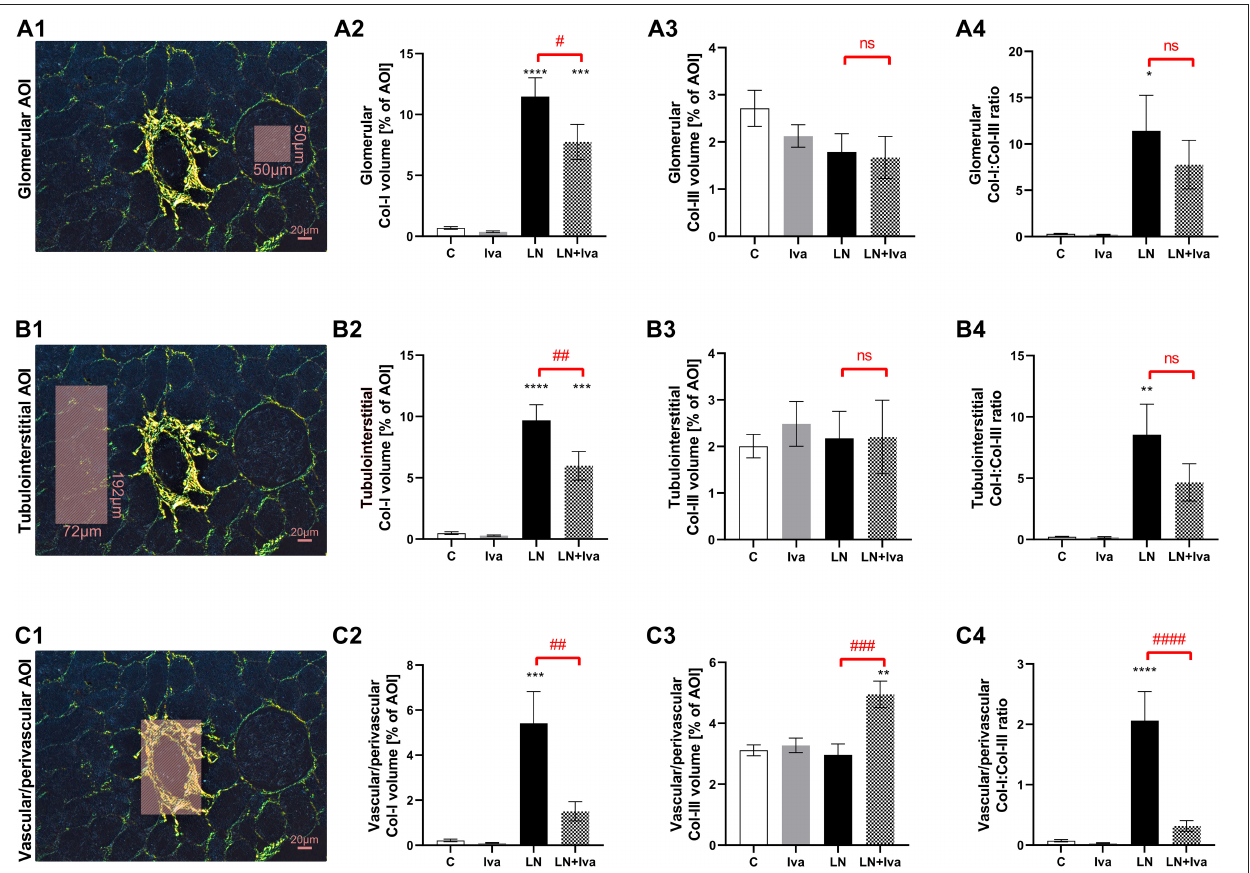
FIGURE 2 | Effect of ivabradine on kidney fibrosis detailed as glomerular (A) , tubulointerstitial (B) , and vascular/perivascular fibrosis (C) in L-NAME-induced hypertension after 4 weeks of treatment. PSR-stained sections at 100x magnification using polarized light microscopy. AOI, area of interest depicted as shaded rectangle; C, controls; Col-I, type I collagen; Col-III, type III collagen; Iva, ivabradine; LN, L-NAME; n = 9 animals per group. One-way two-tailed ANOVA followed by Holm–Sidak post-hoc test ; * P < 0.05 vs. C; ** P < 0.01 vs. C; *** P < 0.001 vs. C; **** P < 0.0001 vs. C; # P < 0.05 vs. LN; ## P < 0.01 vs. LN; ### P < 0.001 vs. LN; #### P < 0.0001 vs. LN; ns, non-significant.